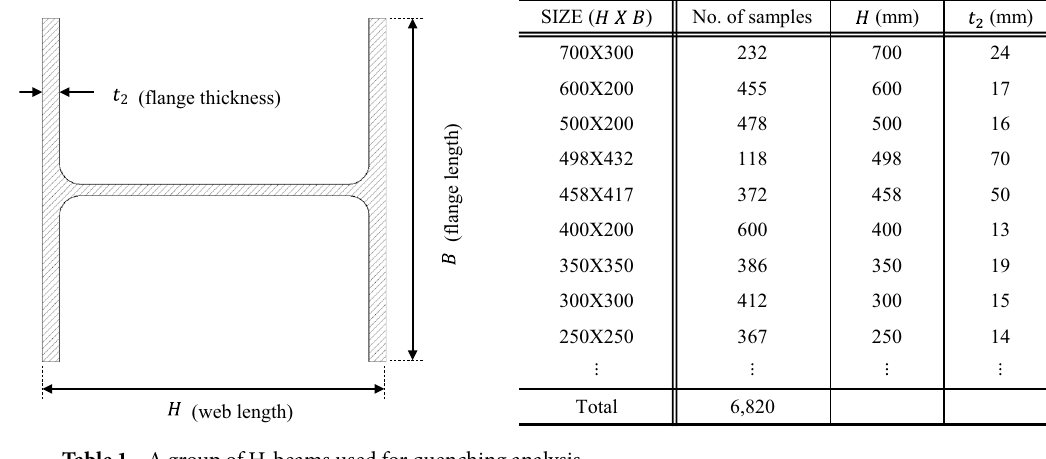
Table 1. A group of H-beams used for quenching analysis.